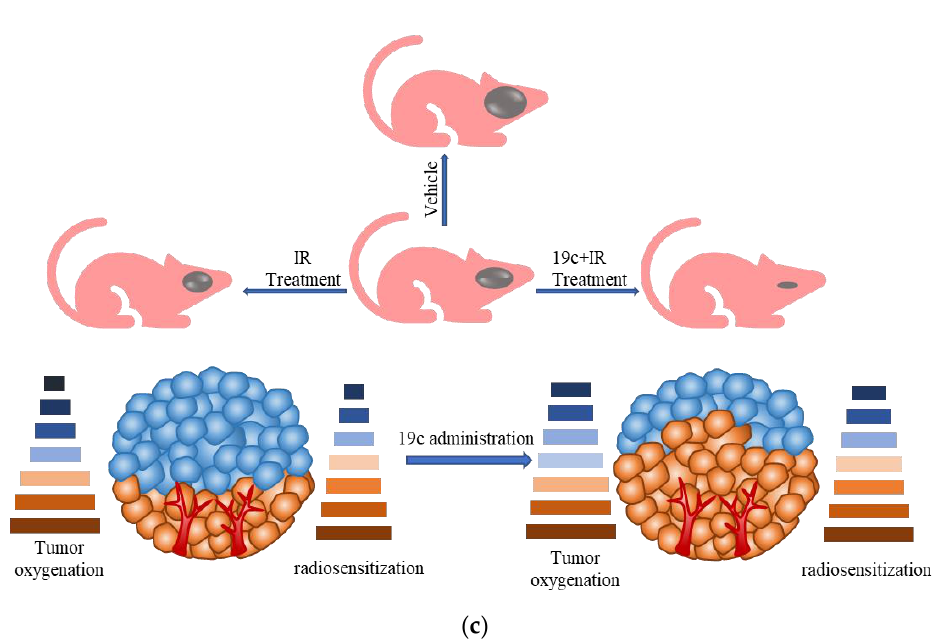
Figure 6. In vivo antitumor effect of compound 19c . ( a ) Luciferase-labeled U87-MG was transplanted into the brains of Balb/c nude mice (8 × 10 5 cells/mouse) and tracked by bioluminescence; the representative images are shown. Mice were randomly grouped and received indicated treatment every four days four consecutive times ( n = 5). ( b ) Quantification of bioluminescence, in which the photon flux was used to characterize tumor size. ( c ) Radiosensitization mechanisms of 19c on hypoxic tumor cells. Statistical analysis was performed by unpaired Student’s t -test for two-group comparisons, Data are means ± SD, n = 5, * p < 0.05.